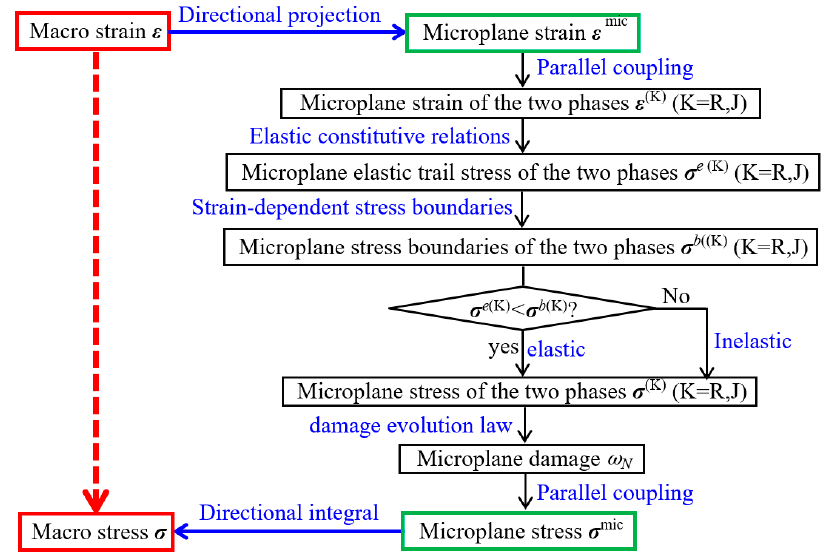
Figure 14. Flowchart of the MPD model for rocks in a VUMAT user subroutine of ABAQUS.